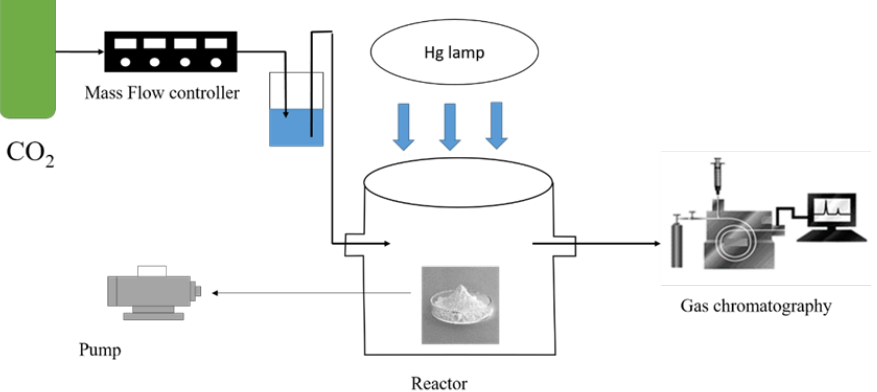
Figure 12. Schematic of the experimental setup for CO 2 photoreduction.